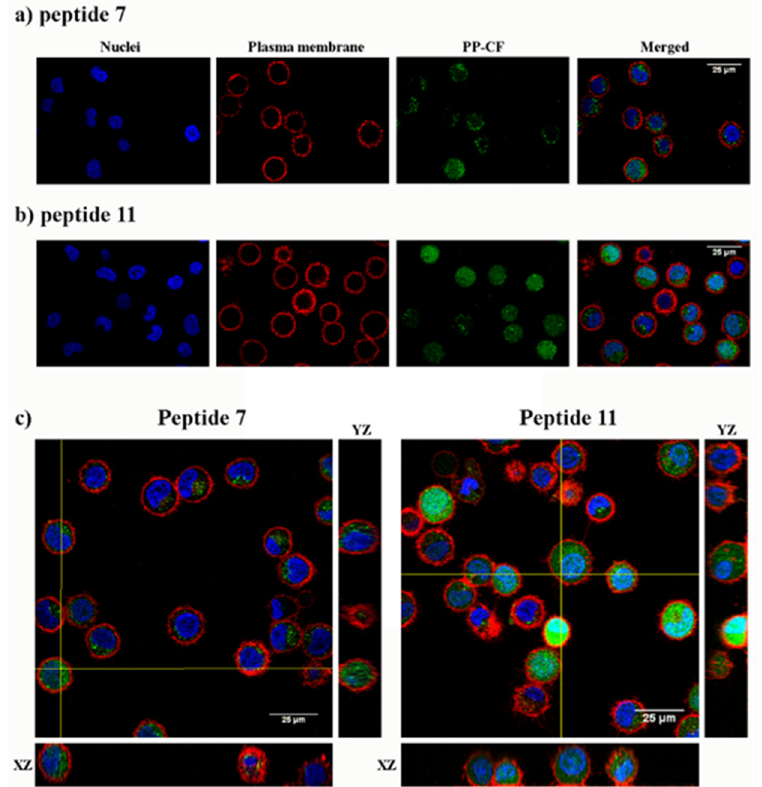
Figure 4. Confocal microscopy of HeLa cells incubated with the carboxyfluoresceinated γ -CC 7 and γ -CT 11 tetradecameric peptides. ( a ) Peptide γ -CC 7 . ( b ) Peptide γ -CT 11 . ( c ) Orthogonal projections highlight the internalization (XZ and YZ) of both peptides. HeLa cells were incubated with the respective CF peptides (2 h, 37 °C; 25 μ M), (green fluorescence λ EXC = 488 nm; λ EM = 510 nm), and additionally stained with CellMask, deep red (red fluorescence, λ EXC = 658 nm; λ EM = 690 nm) and Hoechst (blue fluorescence, λ EXC = 405 nm; λ EM = 460 nm) as a plasma membrane and nucleic acids markers, respectively. Magnification bar: 25 μ m.